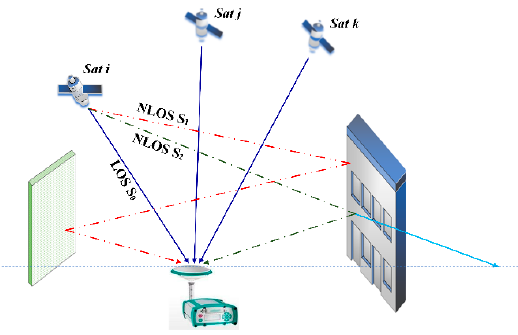
Figure 11. Signal reflection and multipath effects.